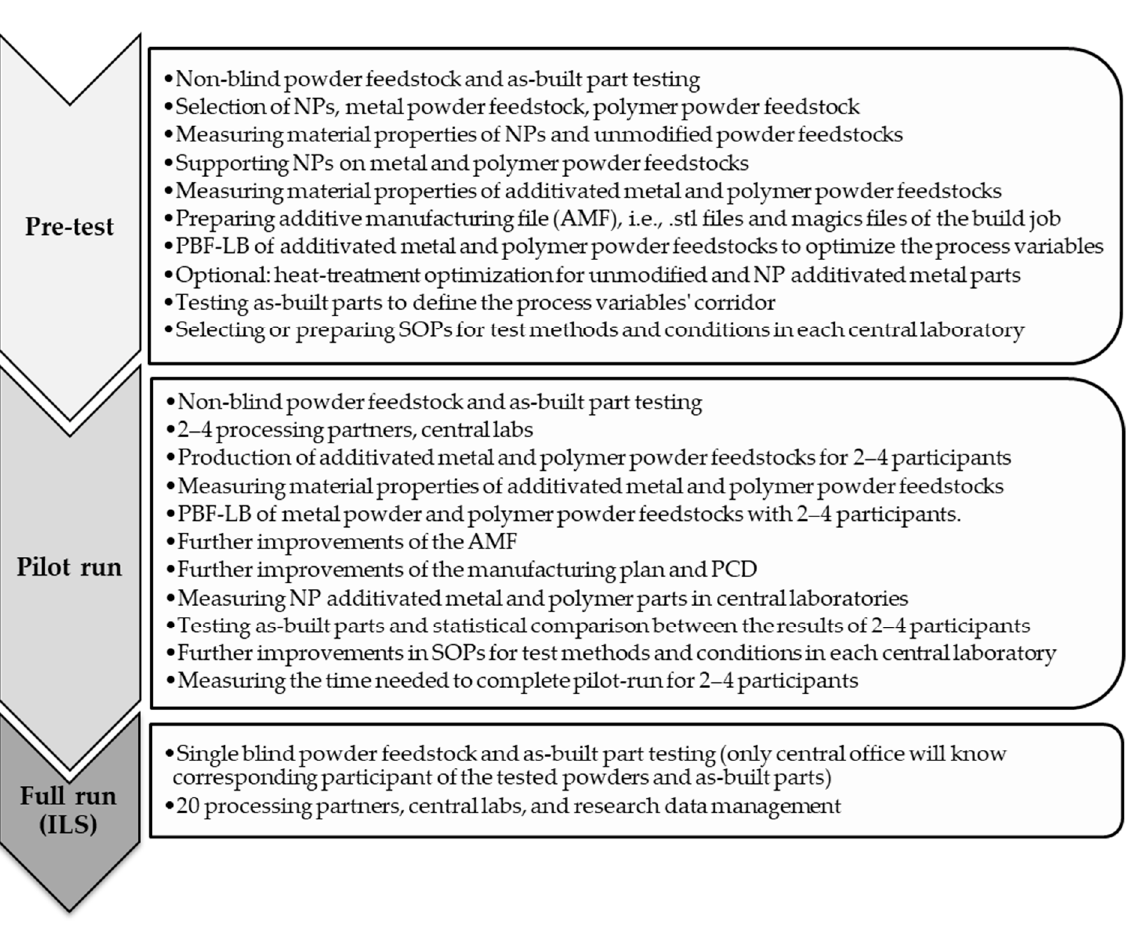
Figure 9. Design of the stepwise inter-laboratory study implementation via execution of pre-test, pilot run, and full ILS run.